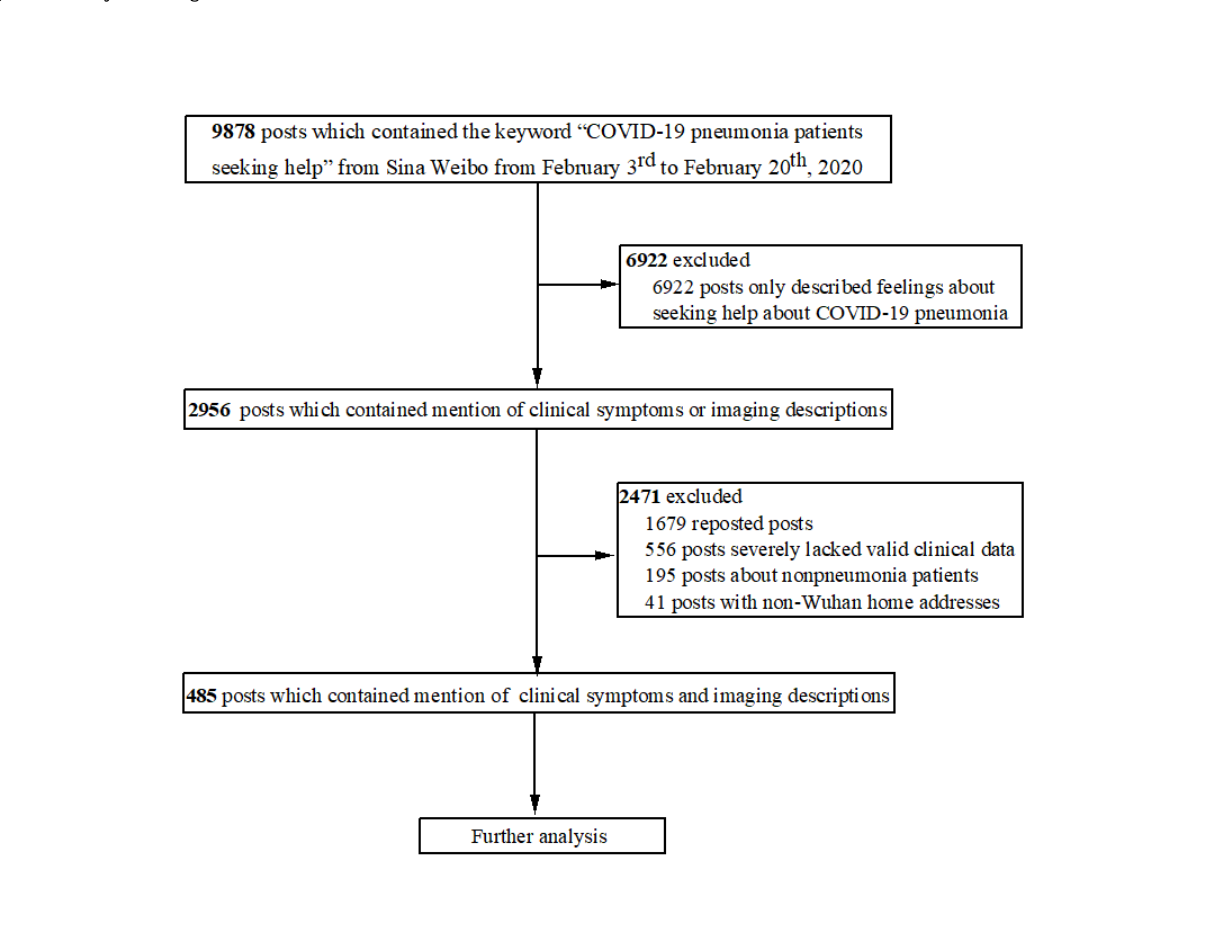
Figure 2. Study flow diagram. COVID-19: coronavirus